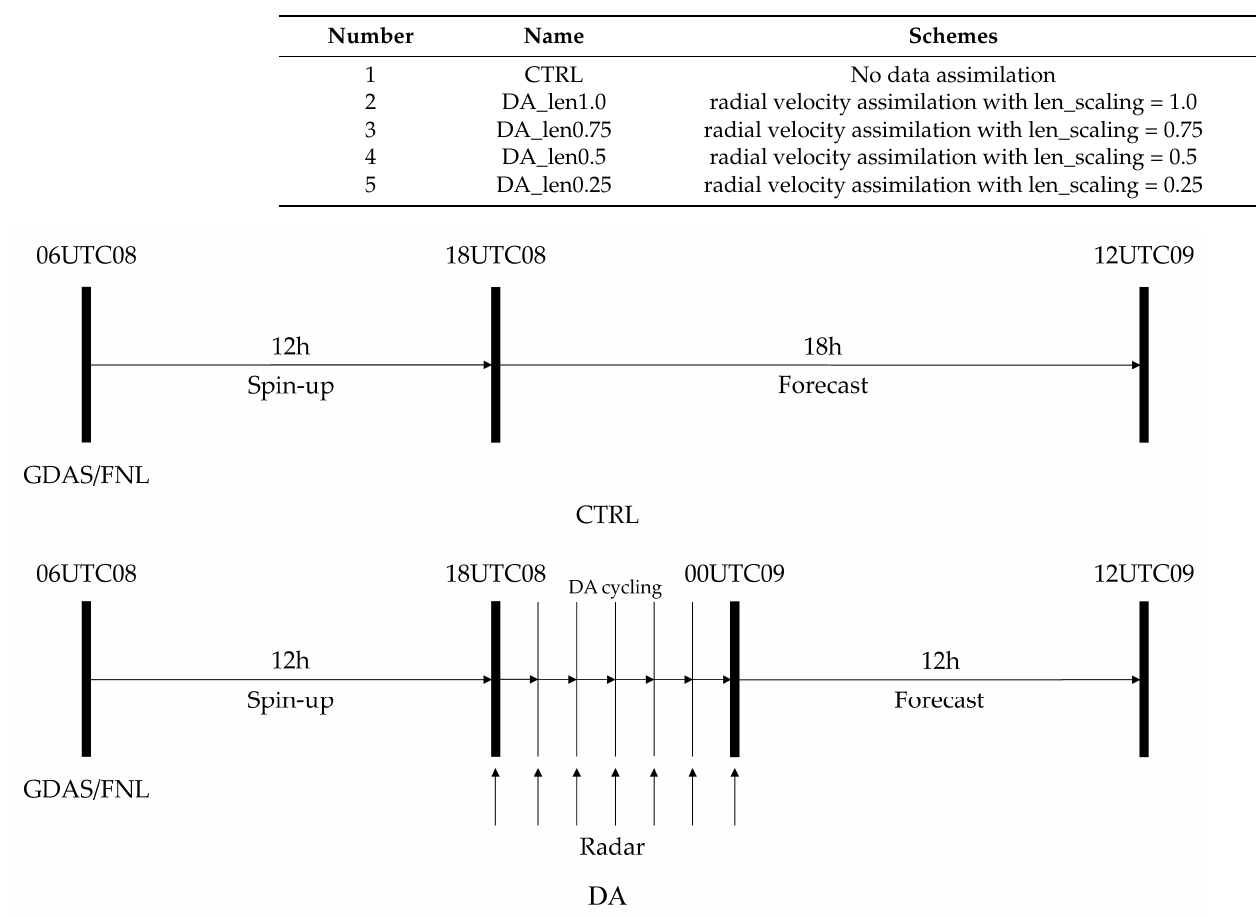
Figure 3. Flow chart of the experiments.